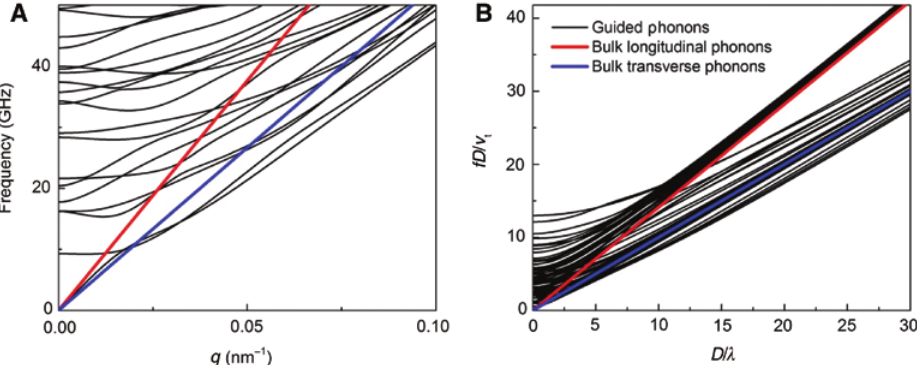
Figure 2: Phonon dispersion relations in nanowires. (A) Phonon dispersion relations in an infinitely long GaAs nanowire of 200 nm of diameter oriented along the (100) directions (black curves) and of longitudinal (red curve) and transverse (blue curve) phonons in a bulk GaAs substrate propagating along the (100) direction for wavelength of the same order as the diameter. (B) Dispersion relations for larger wave vector displayed for a dimensionless wavevector D / λ showing the transition from confined to bulk phonons.